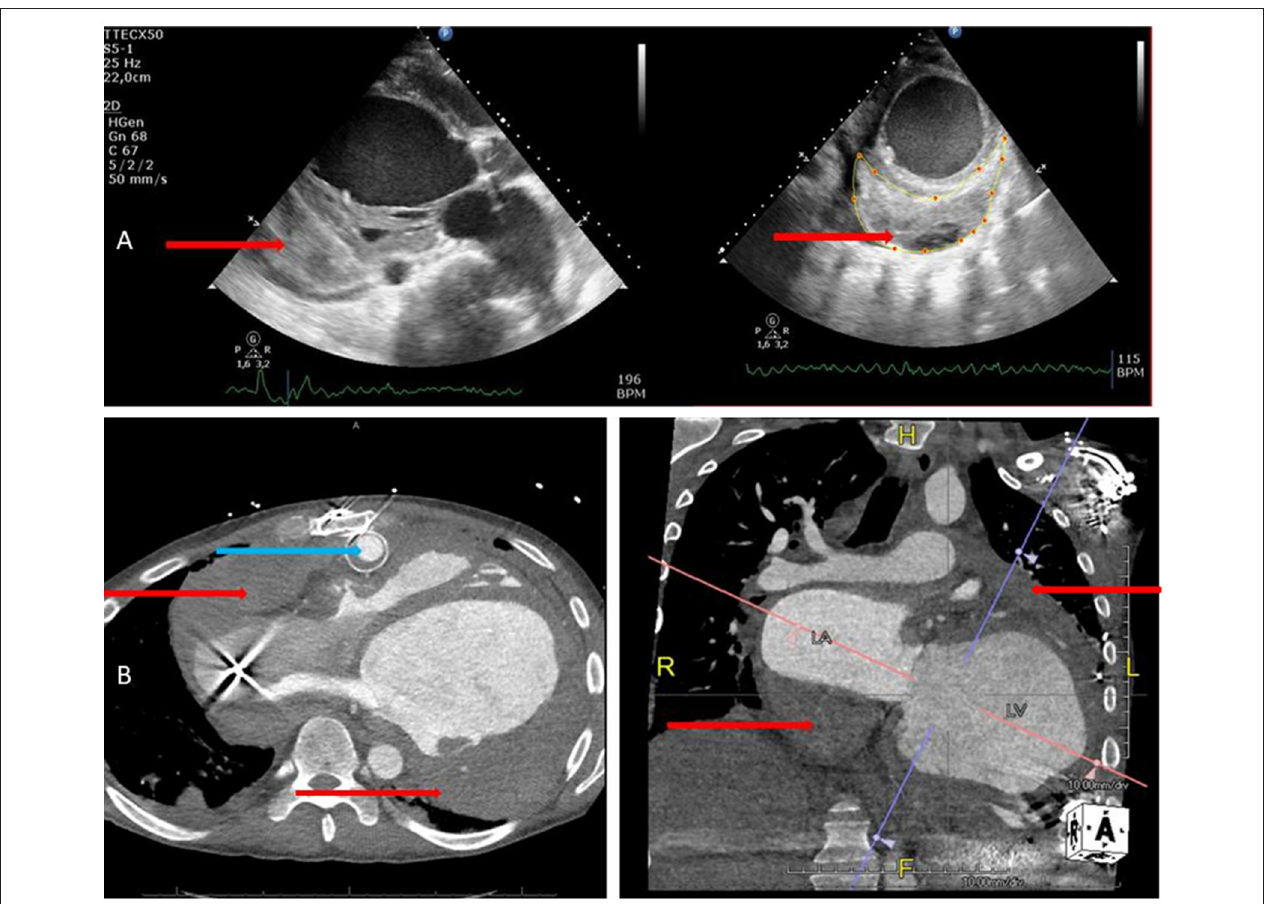
FIGURE 3 | (A) Echocardiography images in parasternal long and short axis views showing thrombus formation (red arrows) in the pericardial space at the posterior area. (B) CT images of the whole thorax from transversal and anterior views showing thrombus formation (red arrows) around the left ventricle, and the atria images collected with echocardiography which are voluminous and more detailed and also show the HeartMate II outflow graft very clearly (blue